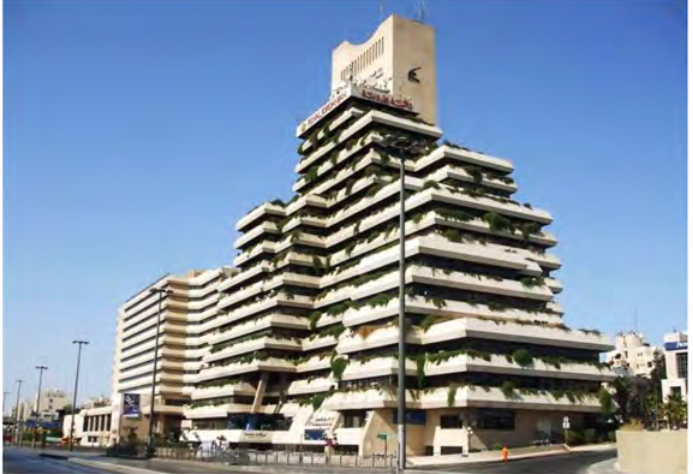
Figure 31. Housing Bank Complex-Amman. Source: photobucket.com